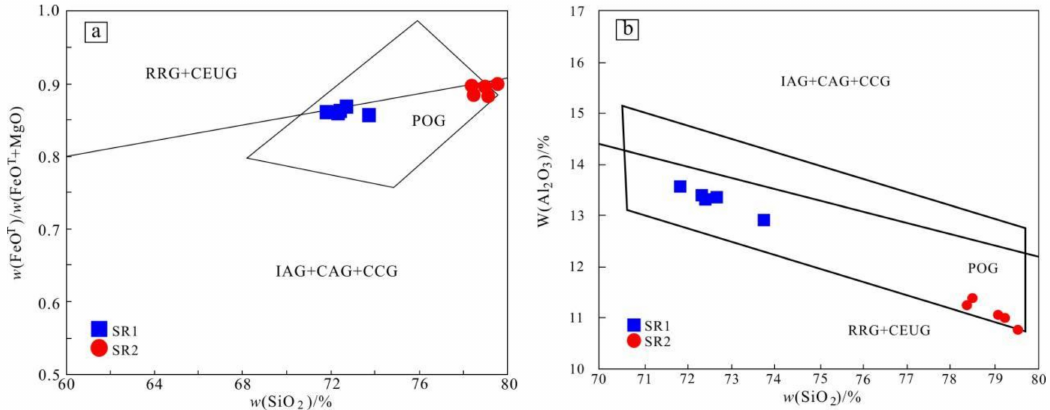
Figure 13. Tectonic environment discrimination diagram: ( a ) Yb–Ta diagram; ( b ) Y+Nb-Rb diagram (base drawing according to [104]). IAG: Island arc granite; CAG: continental arc granite; CCG: continental collision granite; POG: post-orogenic granite; RRG: rift-related granite; CEUG: continental uplift granite; OP: oceanic